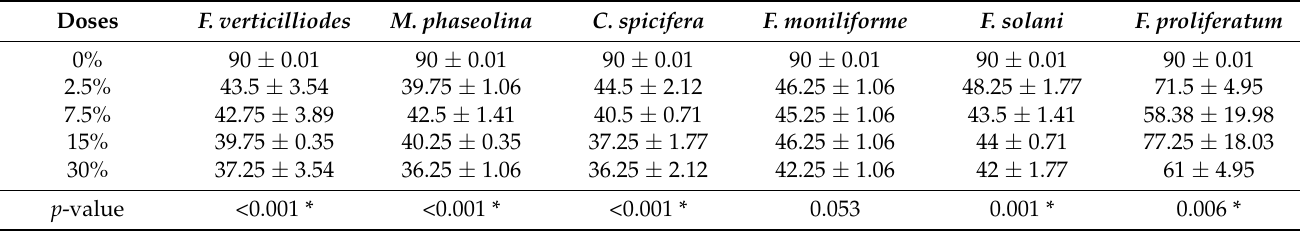
Figure 2. Effect of different concentrations (0, 2.5, 7.5, 15, and 30%) of T. aphylla water extract on growth of different phytopathogenic fungi. The extract showed variable inhibitory effects on the growth of different phytopathogenic fungi cultured on PDA agar medium. Bars indicate the standard error. Table 1. Effect of different concentrations of T. aphylla water extract on growth of different phytopathogenic fungi.